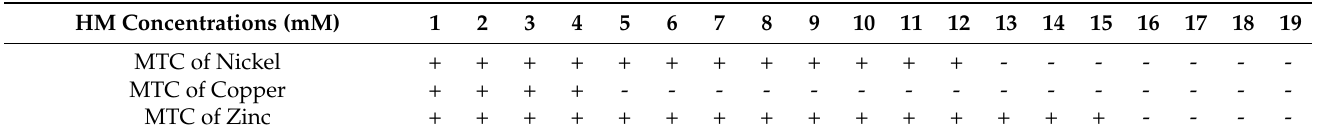
Table 3. Maximum tolerable concentration shown by M. radiotolerans MAMP 4754 against heavy metals. HM Concentrations (mM) MTC of Nickel MTC of